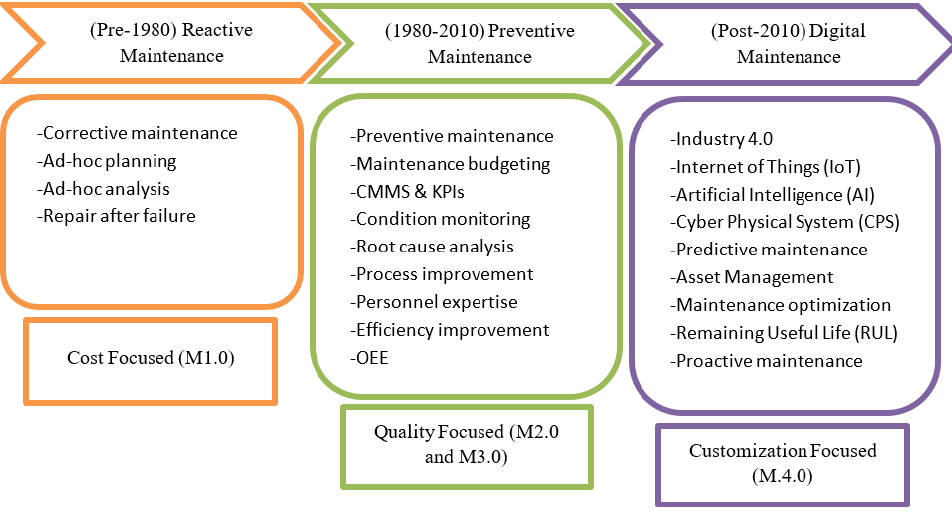
Figure 1. The maintenance journey towards digitalization